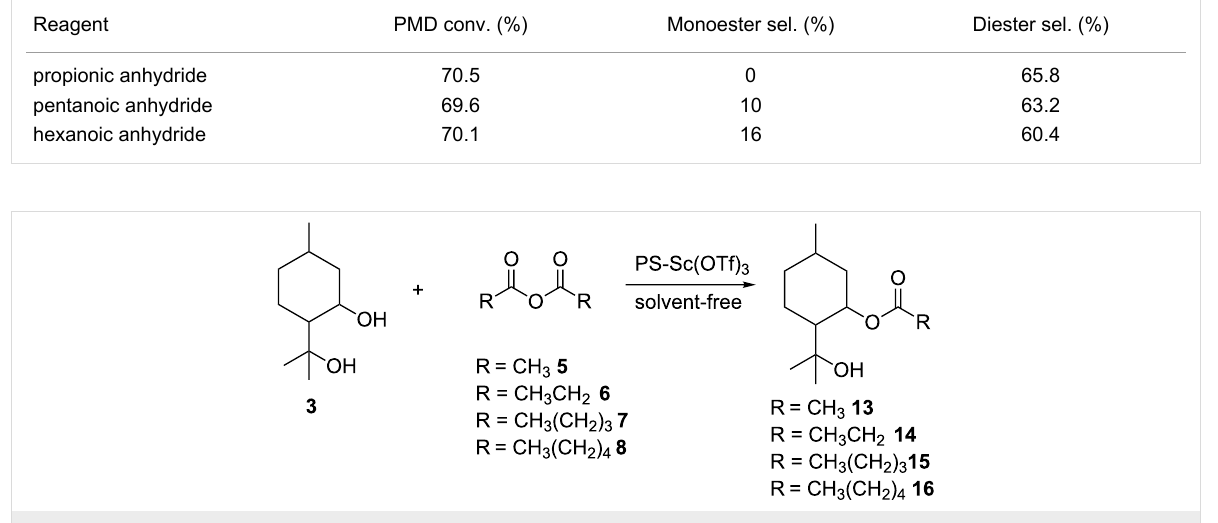
Table 1: Synthesis of propyl, pentyl and hexyl